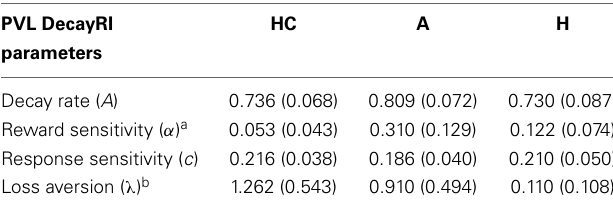
Table 6 | Means and standard deviations (in parentheses) of group mean parameters with the PVL-Delta